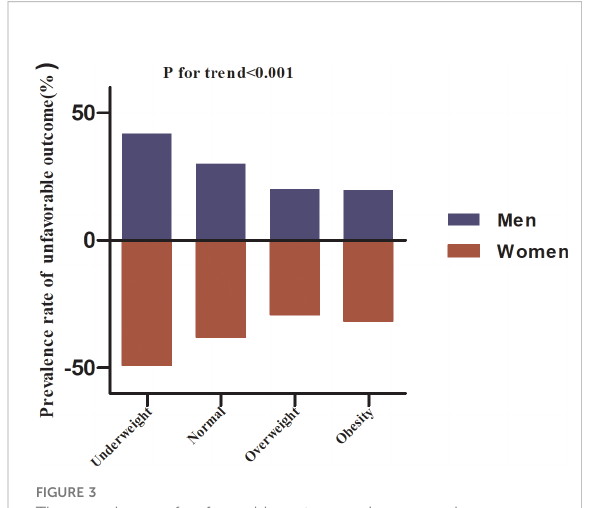
FIGURE 3 The prevalence of unfavorable outcomes in men and women according to BMI classi fi cation.